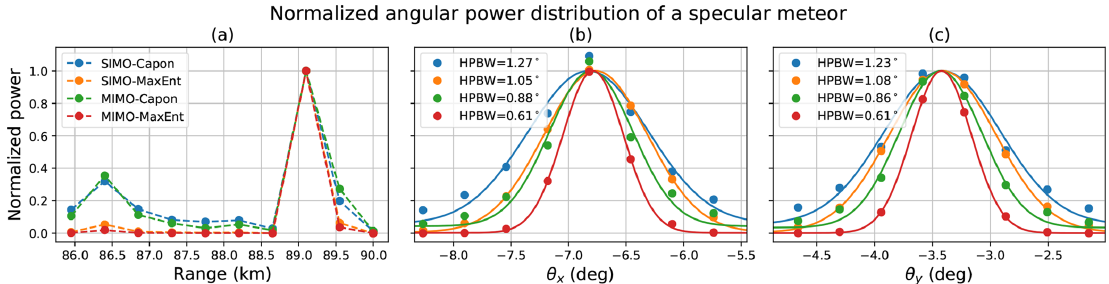
Figure 10. Normalized angular power distribution of a specular meteor echo as a function of (a) range, (b) EW angle ( θ x ), and NS angle ( θ y ). The results are shown for all four implementations, i.e., SIMO-Capon (blue), SIMO-MaxEnt (orange), MIMO-Capon (green), and MIMO-MaxEnt (red). Table 2. Performance of imaging techniques. Technique Angular Spatial Equivalent Improvement resolution resolution antenna factor at 85km aperture